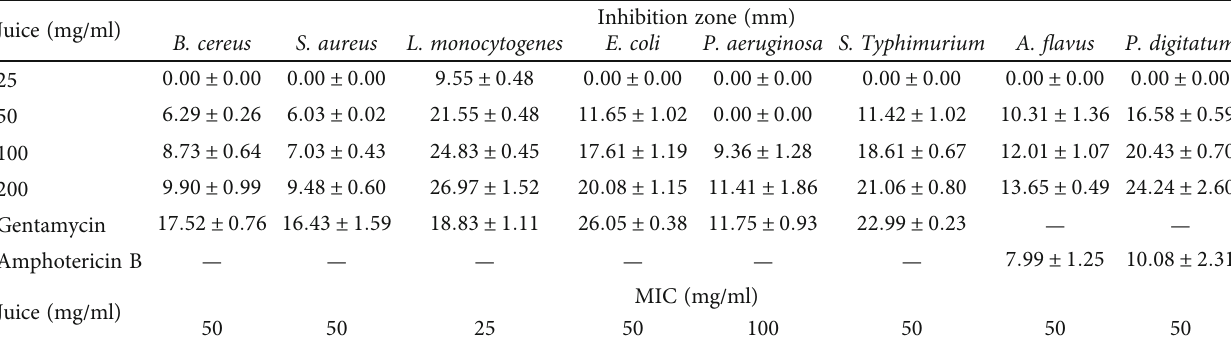
Values are shown as mean ± standarddeviation ( n = 3 ). DPPH: 2, 2-diphenyl-2-picrylhydrazyl; ABTS: 2,2 ′ -azino-bis (3-ethylbenzothiazoline-6-sulfonic acid) diammonium salt; FRAP: ferric-reducing antioxidant power; EC 50 : half maximal e ff ective concentration; TEAC: trolox equivalent antioxidant capacity; TE: trolox equivalent. Table 3: Inhibition zones related to MIC using di ff erent Mao fruit juice concentrations. Juice